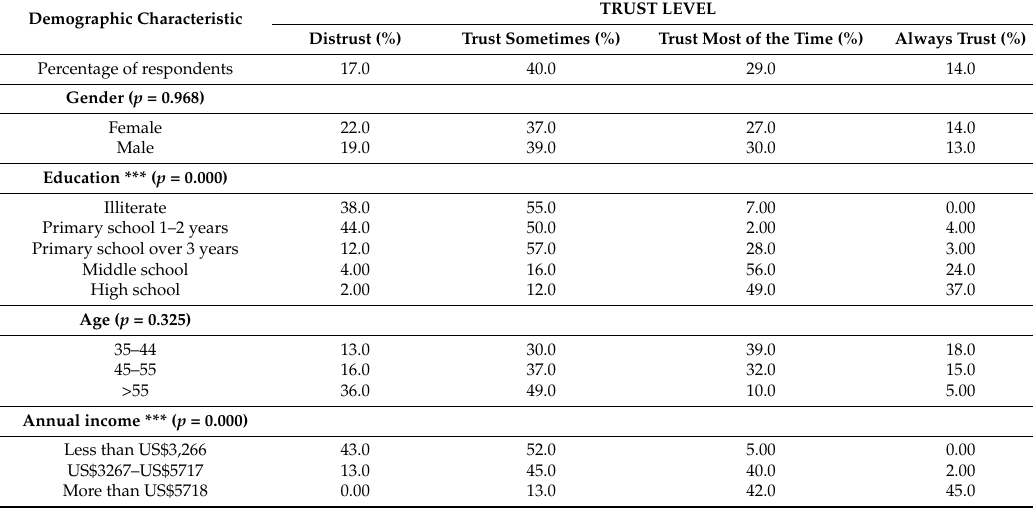
Table 4. Trust levels in relation to demographic characteristics.